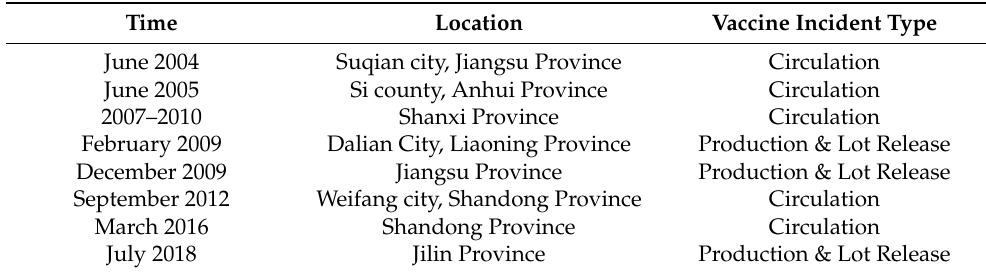
Table 1. Vaccine incidents in the last two decades. Time